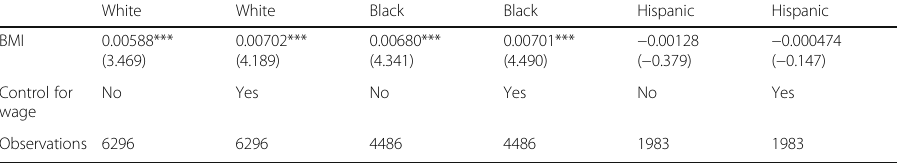
Table 7 BMI and log hours of work for single women: excluding women with health limitations White White Black Black Hispanic Hispanic BMI 0.00588*** 0.00702*** 0.00680*** (3.469) (4.189)